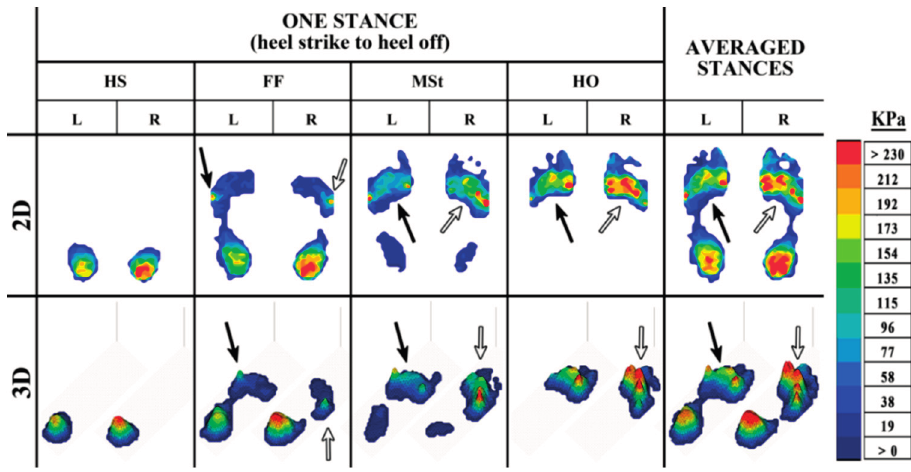
Figure 4. The 2D and 3D representation of an in-shoe plantar pressure distribution resulting from metatarsalgia in the pathological foot during the stance phase of the gait cycle, from HS to HO, and the averaged pressure distribution from four